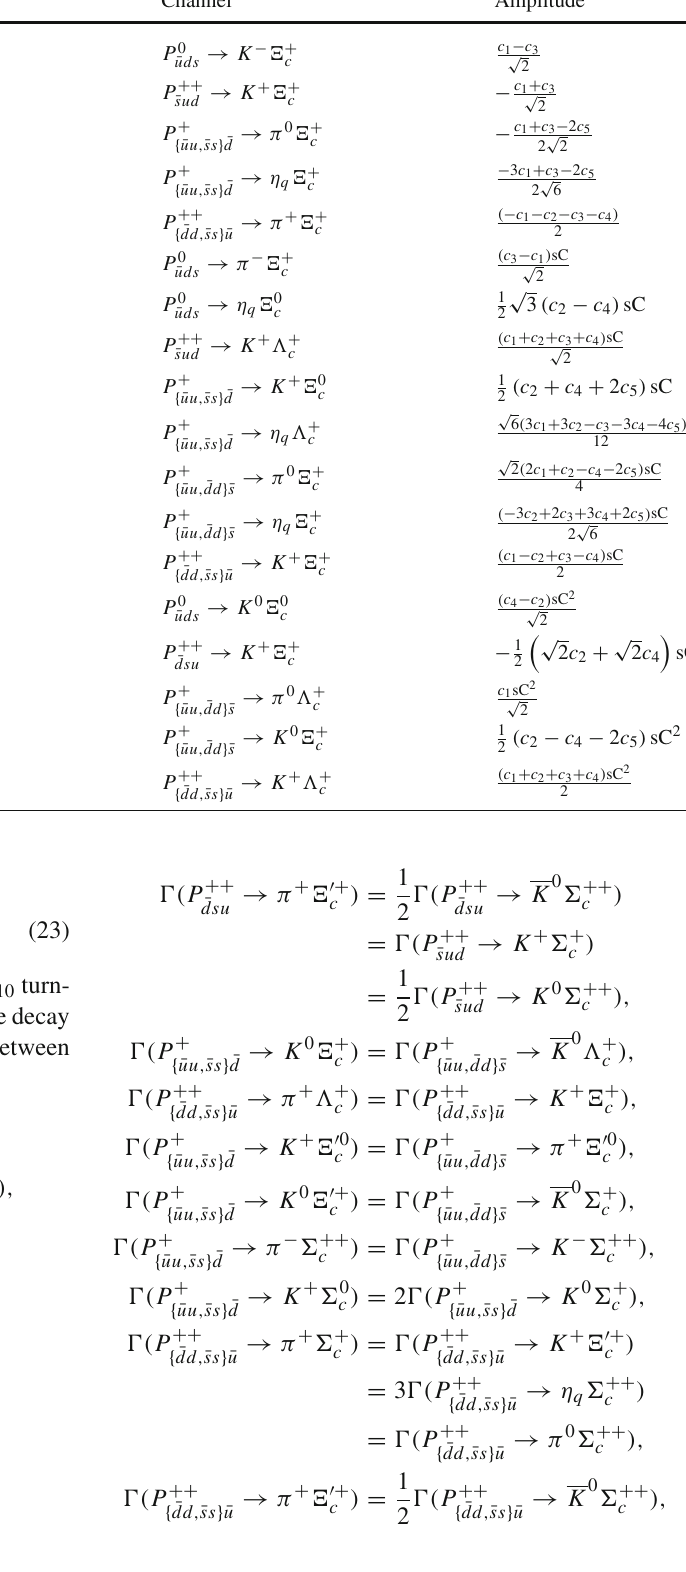
Table 6 Pentaquark P 6 ( cc ¯ qqq ) decays into light mesons and singly charmed baryons triplet with Cabibbo allowed, the singly Cabibbo suppressed and doubly Cabibbo suppressed Channel Amplitude Channel Amplitude → K 0 (cid:6) 0 P 0 ¯ uds